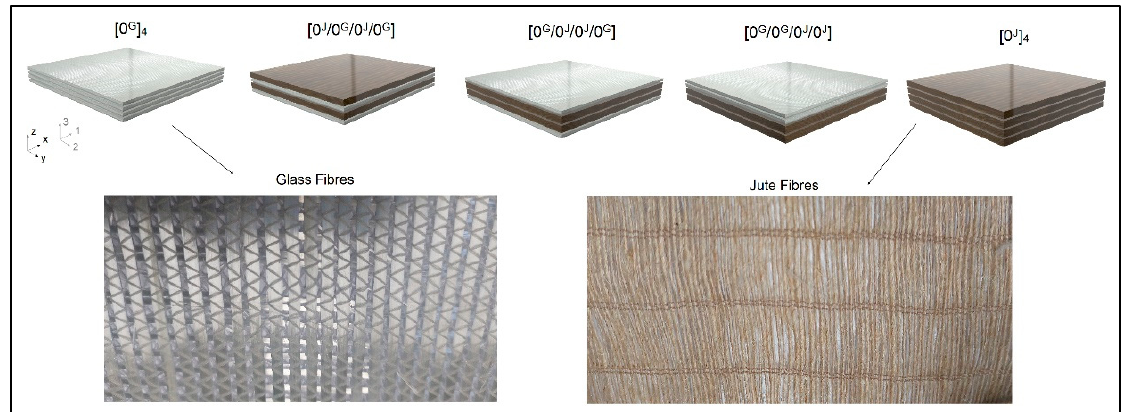
Figure 1. Stacking sequence and nomenclature adopted for the studied laminates.